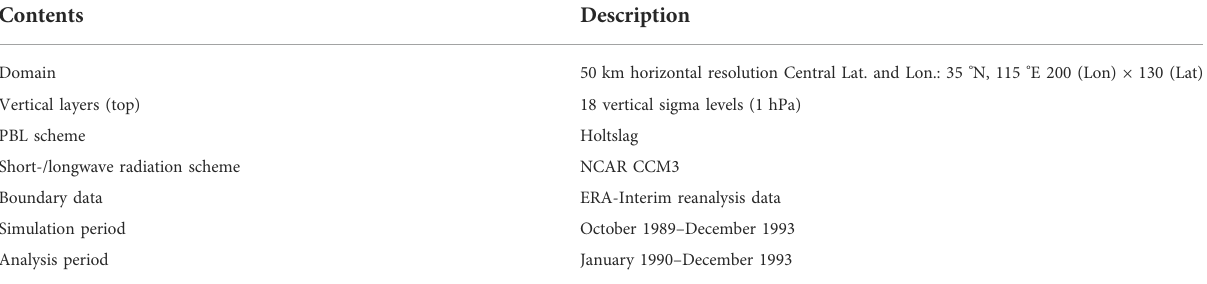
TABLE 1 RegCM4 model con fi guration used in this